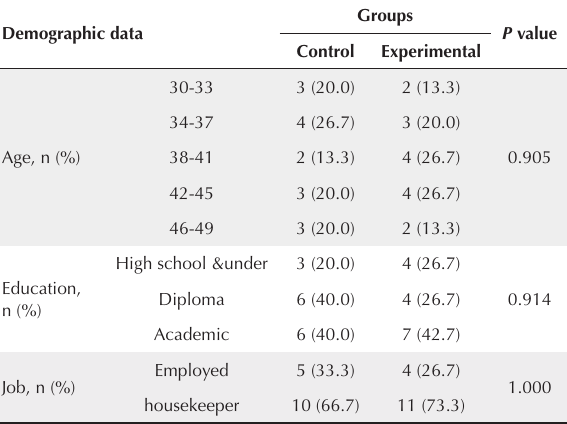
Table 2. Comparing demographic data of participants in experimental and control groups Demographic